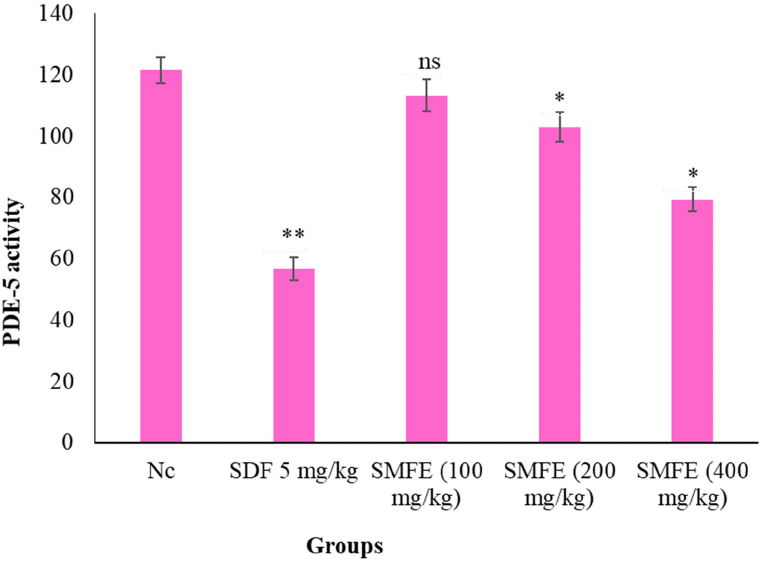
Figure 10. Effects of SMFE on phosphodiesterase level ( n = 6). The values are means ± SEM; * p < 0.05, ** p < 0.1; ns p > 0.05.